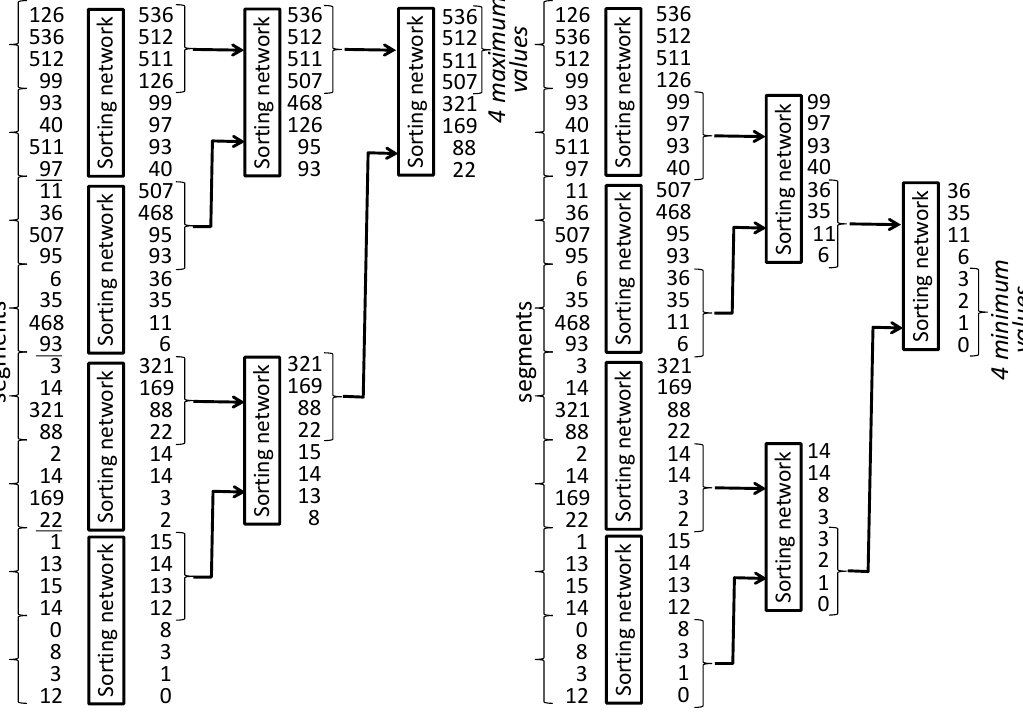
Fig. 9. Discovering groups with t /2 maximum and t /2 minimum